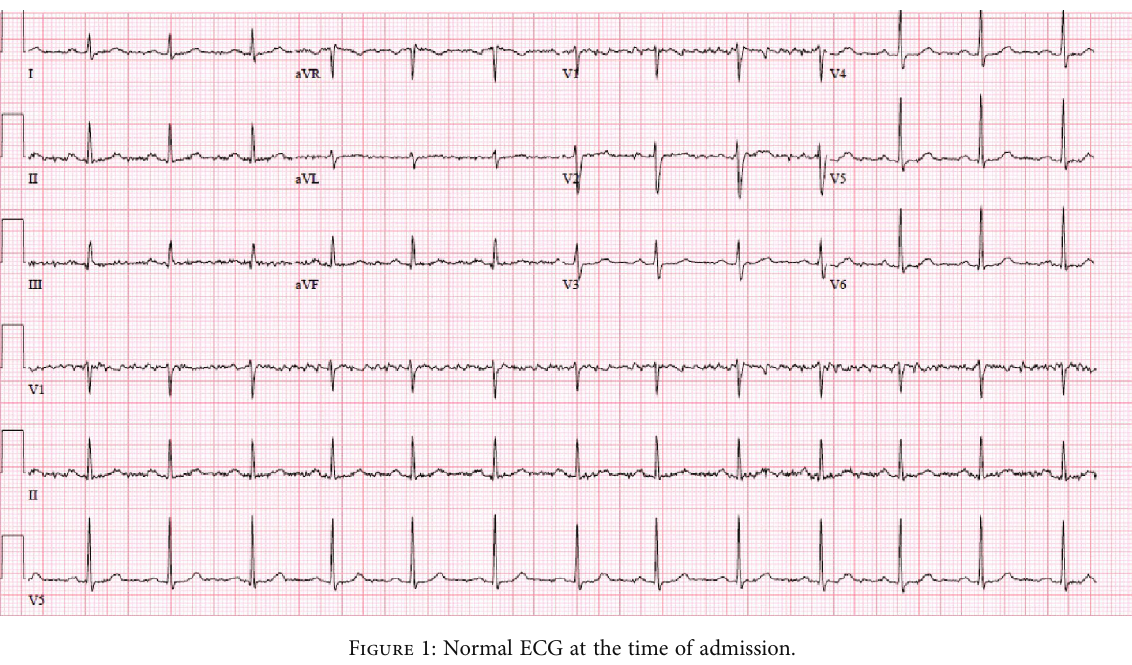
Figure 1: Normal ECG at the time of admission.